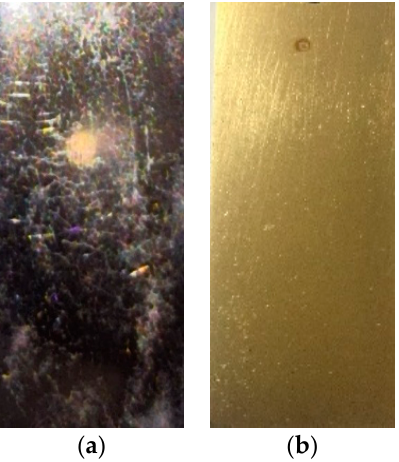
Figure 5. The morphology of ( a ) Ti-6Al-4V titanium alloy, and ( b ) TiN/ZrN coating after salt spray corrosion.